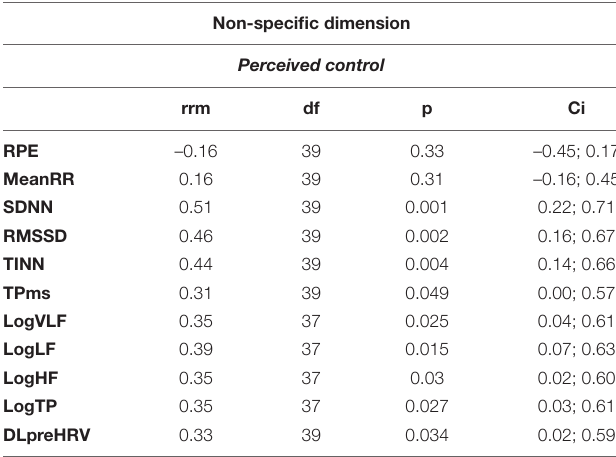
TABLE 3 | Repeated measures correlation values between PC and time-domain and spectral